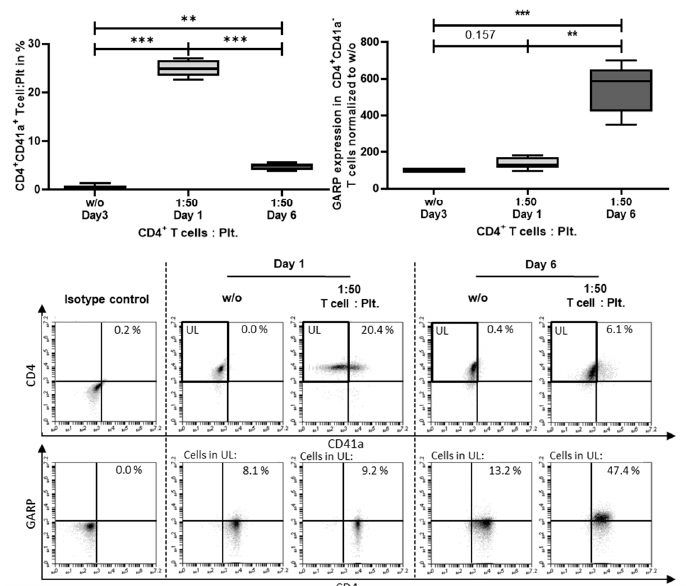
Figure A2. Platelets bound to T cells upon activation in coculture. CD4 + CD25 − T cells were cocultured with or without platelets at the ratio of 1:50 and stimulated with 0.5 µg/mL anti-CD3 mAb and 1.0 µg/mL anti-CD28 mAb for 6 days. At day 1 and 6, platelet–T cell conjugates (CD41a + CD4 + double-positive cells) were analyzed via flow cytometry. For assessment of GARP expression, only CD4 + CD41a- cells were included in the analysis (indicated by the pregating on the upper left (UL)). GARP expression was normalized to the untreated (w/o) control. Dot plots show one representative result of five independent experiments. Isotype controls are shown ( n = 5, box and whiskers, medians + min/max, ** p ≤ 0.01, *** p ≤ 0.001, and n.s. determined by one-way ANOVA).